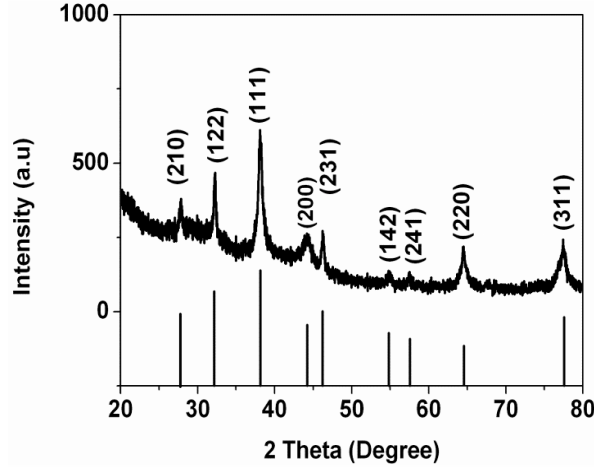
Figure 4. X-ray diffraction (XRD) pattern of obtained Ag